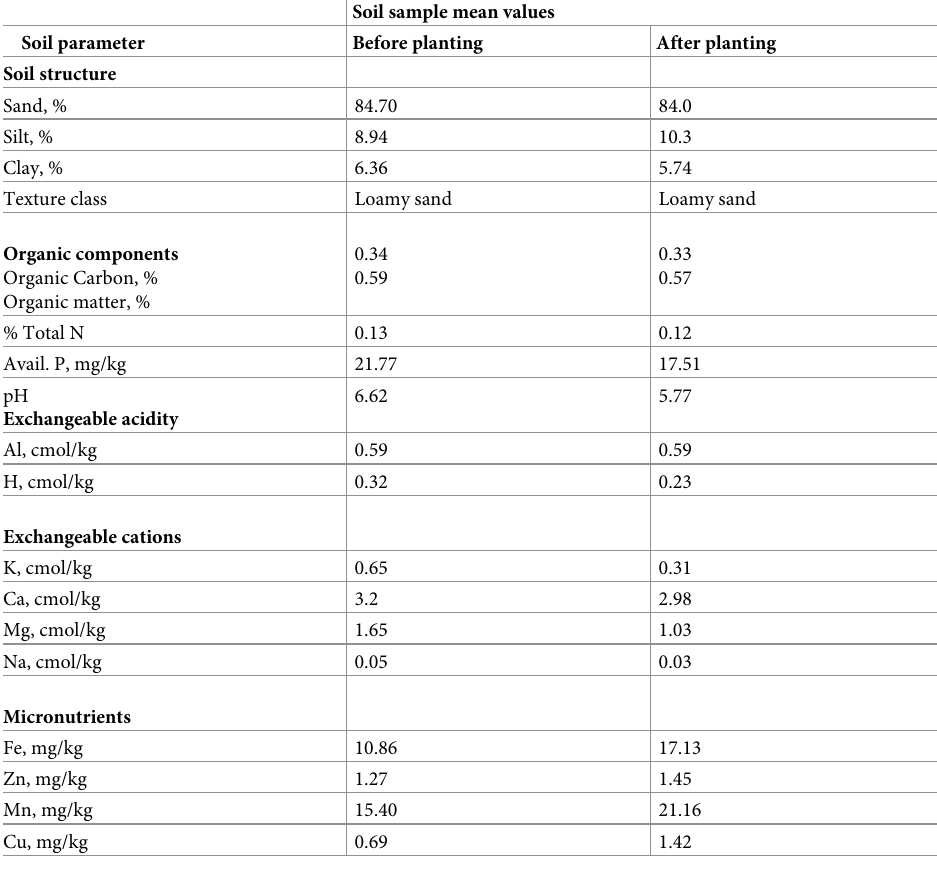
Table 1. Soil structure, chemical reaction, and nutrient content of the study site.